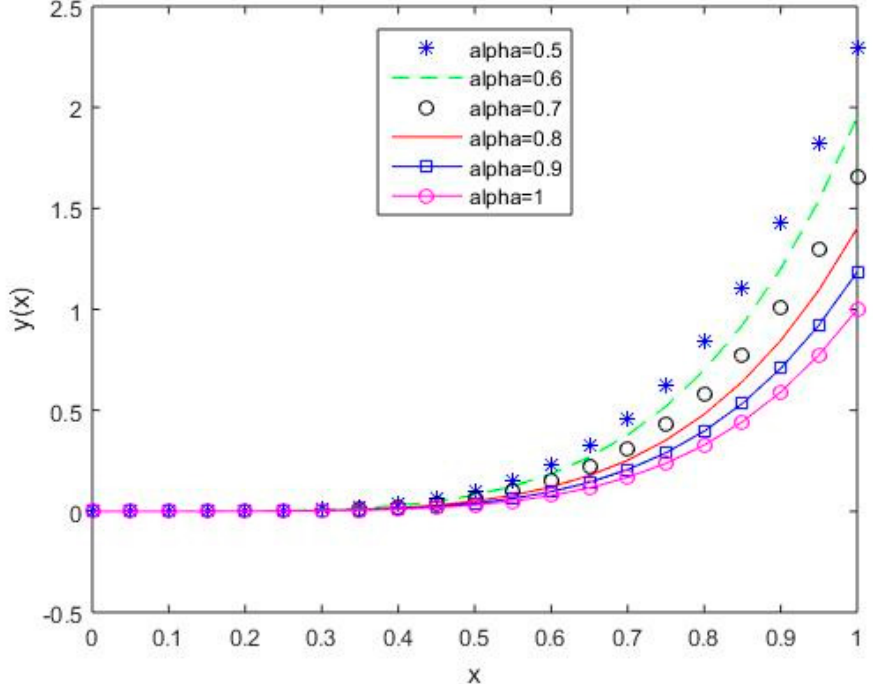
Figure 9. The behavior of solutions using S4 for α values of 0.5, 0.6, 0.7, 0.8, 0.9, and 1, Example 1.